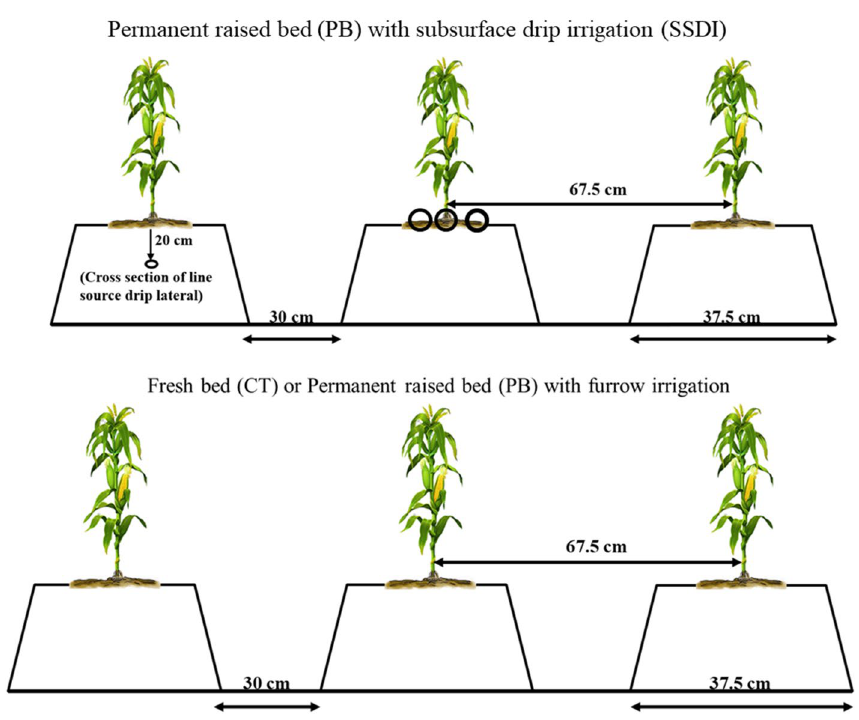
Figure 8. Land configuration and root sampling design (presented by circles) for two contrasting tillage and irrigation management